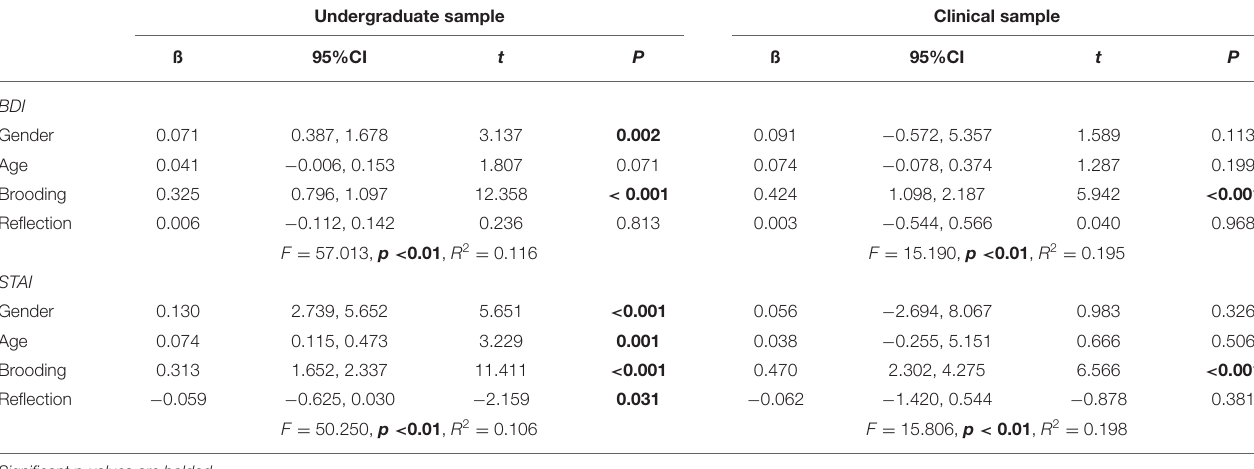
TABLE 3 | Multiple regression analyses with BDI total score (above) and STAI total score (below) as the dependent variable. Undergraduate sample Clinical sample